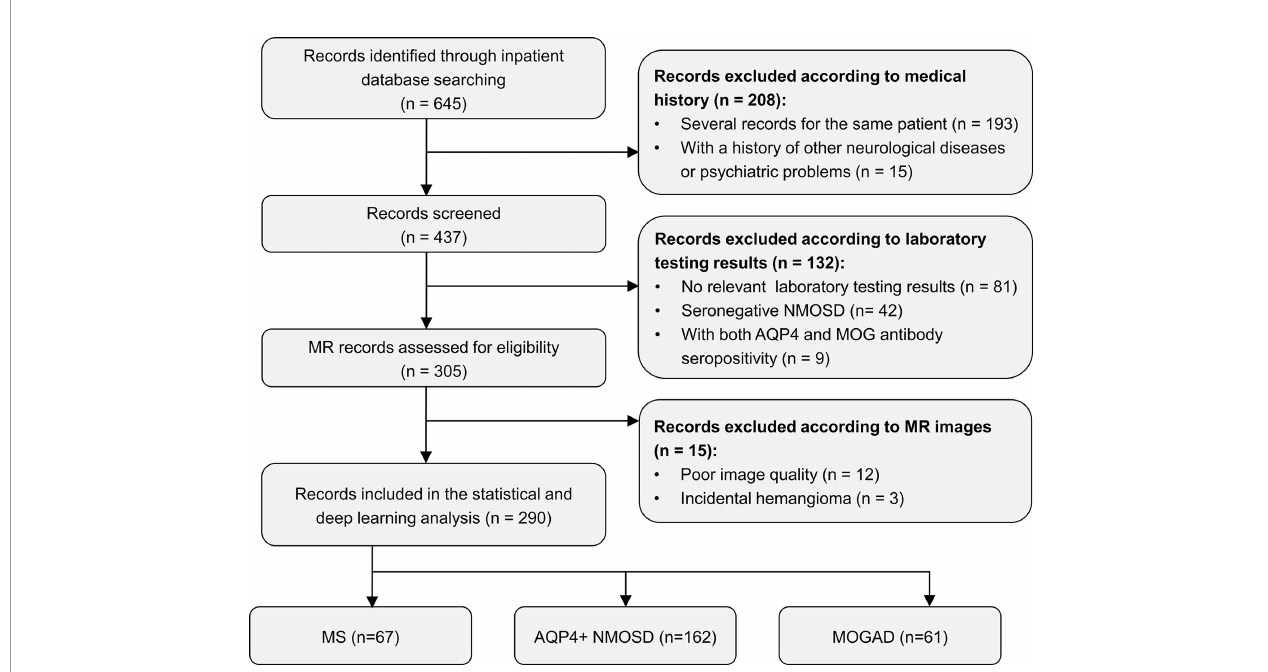
FIGURE 1 | Flow chart of the selection process of included participants. AQP4+ NMOSD, aquaporin 4 positive neuromyelitis optica spectrum disorders; MOGAD, myelin oligodendrocyte glycoprotein antibody associated disease; MR, magnetic resonance; MS, multiple